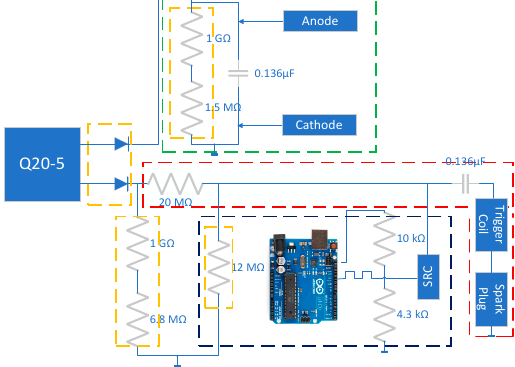
Figure 7. Circuit Schematic.